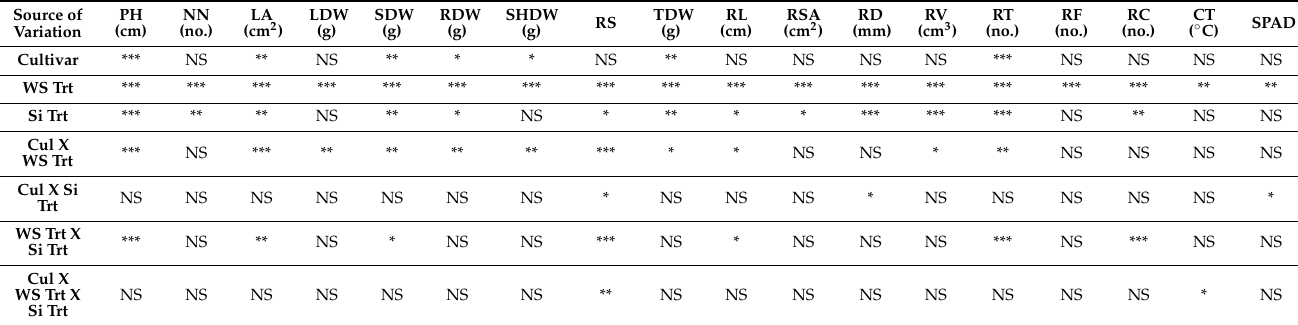
Table 1. Analysis of variance across the silicate treatments and their interactions of growth and development, biomass production, and partitioning and physiological traits of soybean plants: plant height (PH), number of nodes (NN), leaf area (LA), leaf dry weight (LDW), stem dry weight (SDW), root dry weight (RDW), shoot dry weight (SHDW), root/shoot ratio (RS), total dry weight